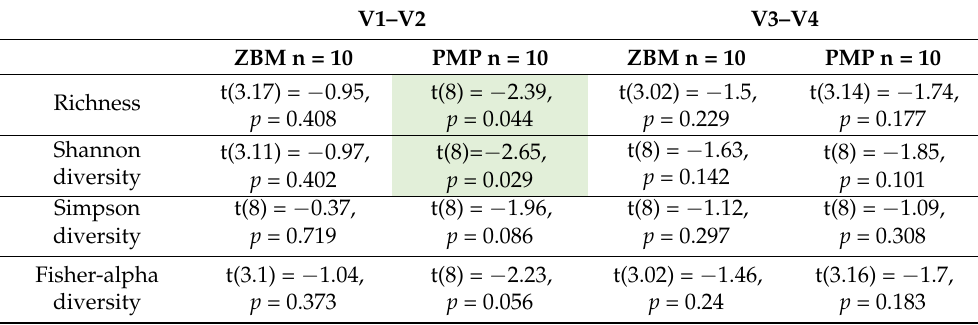
Table 2. Prevalence of taxa when sequenced with primer pair V1–V2 compared to V3–V4; significant differences highlighted in